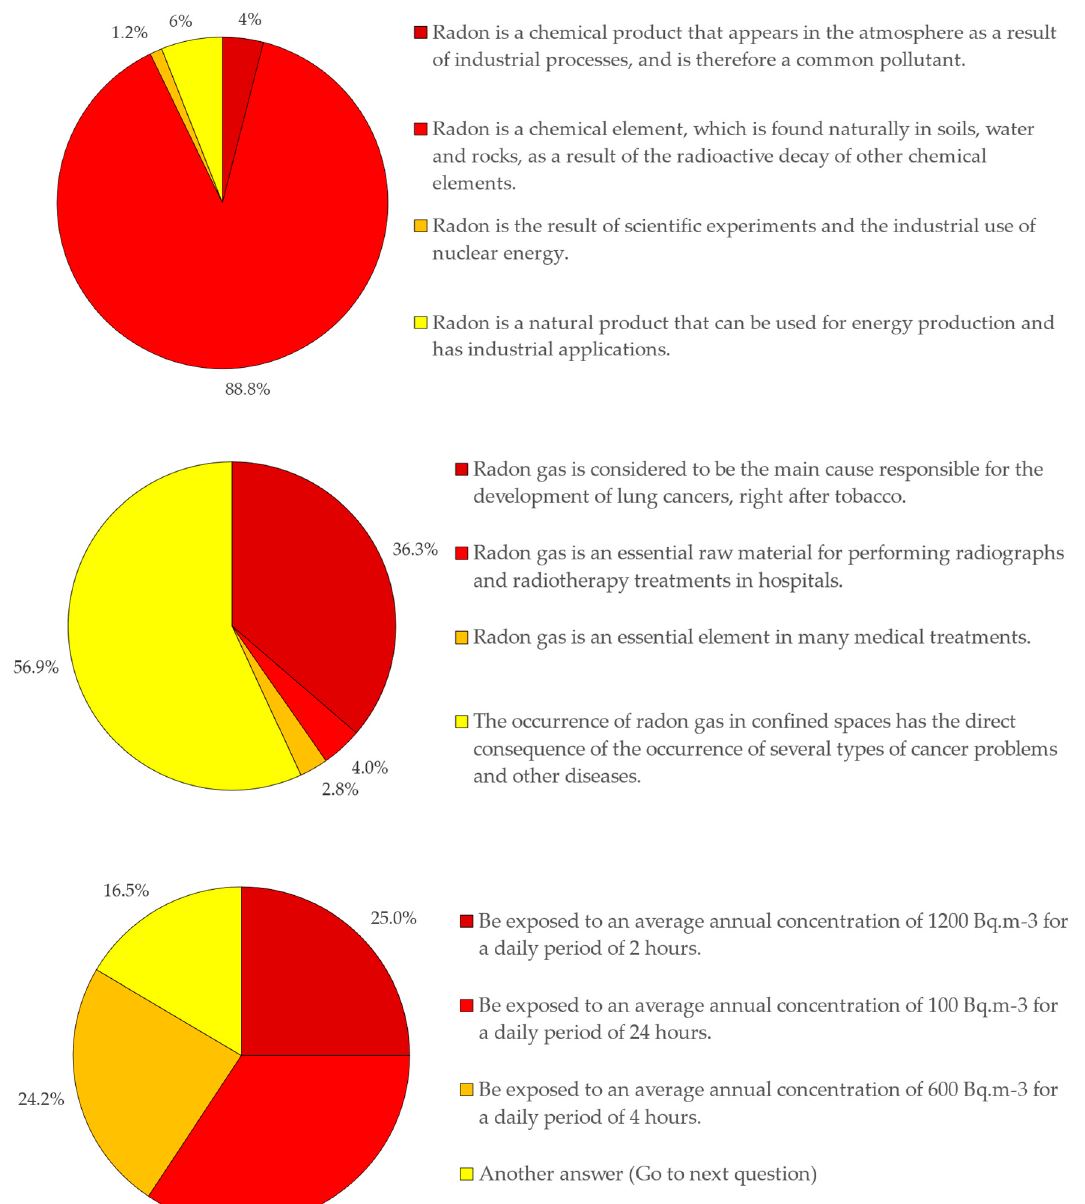
Figure 8. Results extracted from Step 2.